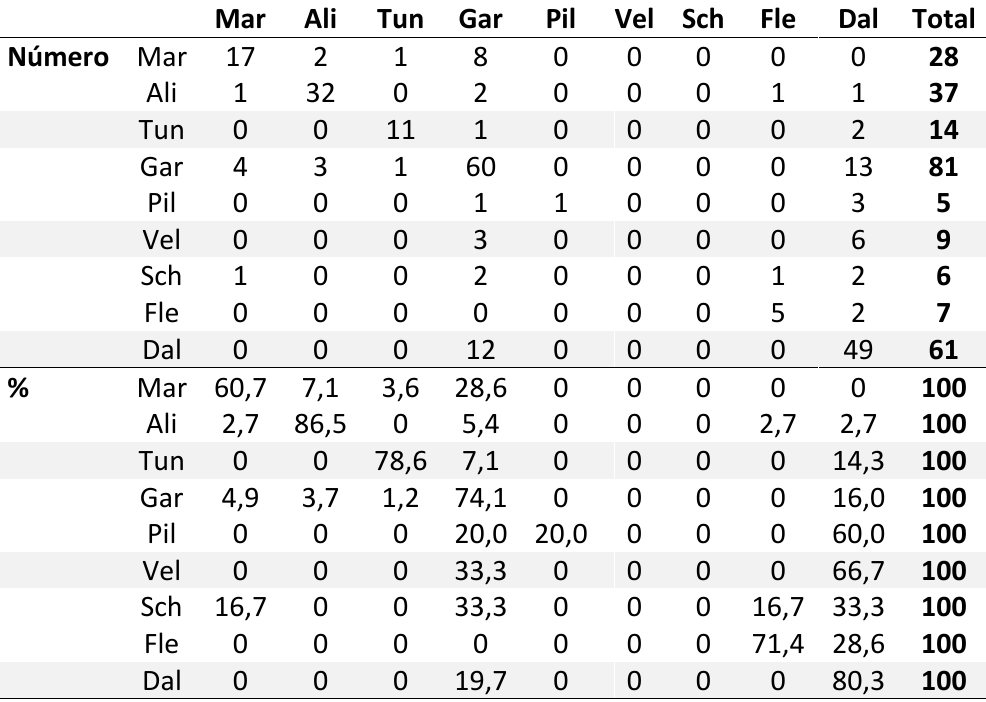
Table 8. Results of the classification of Discriminant Functions